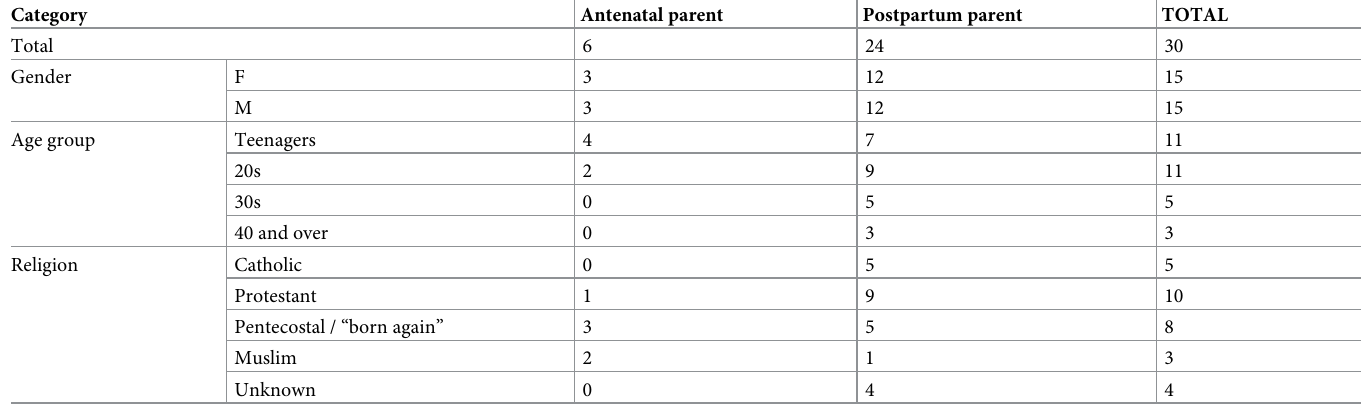
Table 1. Characteristics of the 15 couples in which both partners were